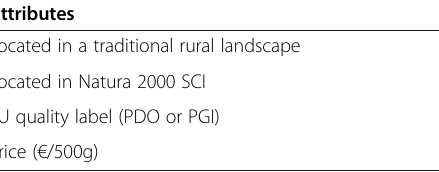
Table 1 Choice experiment attributes and levels Attributes Levels Located in a traditional rural landscape